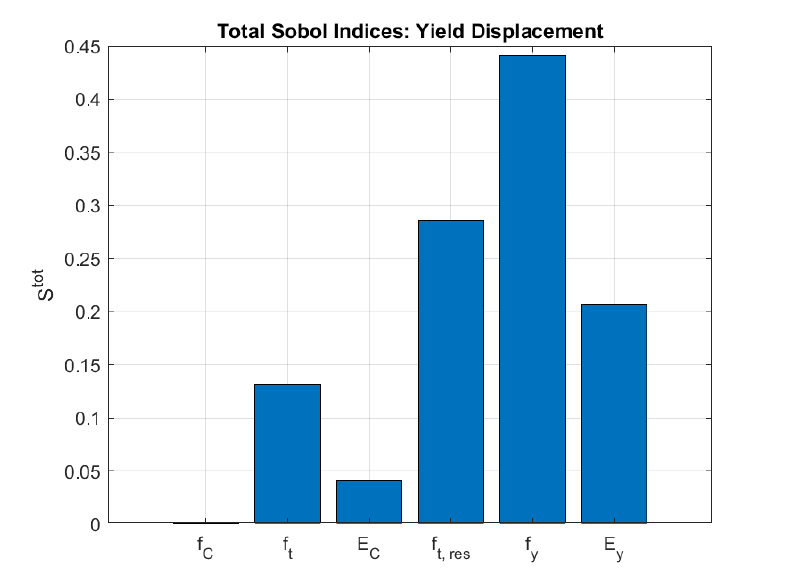
Figure 17. Total Sobol’ indices for yield displacement.